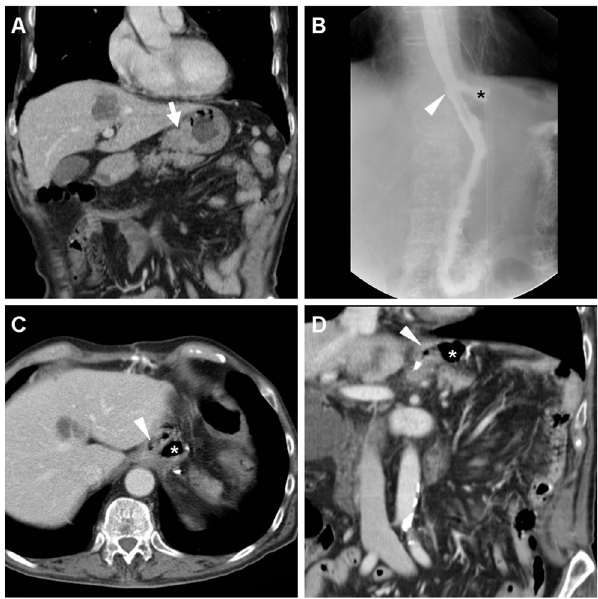
Fig. 3 In a 74-year-old male, preoperative CT (A) depicted a stricturing carcinoma of the gastric body (thick arrow). Six days after uncomplicated total gastrectomy with lymphadenectomy and splenectomy, CF (B) visualized normally patent EJS (arrowhead) with a seemingly extraluminal contrast medium accumulation (*) which corresponded to anastomotic recess ofthe Roux-en-Y EJS at surgical correlation, a finding which potentially mimics leakage if technical details are not known. Corresponding expected postsurgical CT changes including air-filled anastomotic recess (*), non-stapled EJS (arrowheads) with unremarkable perianastomotic fat planes, no abnormal collections in the